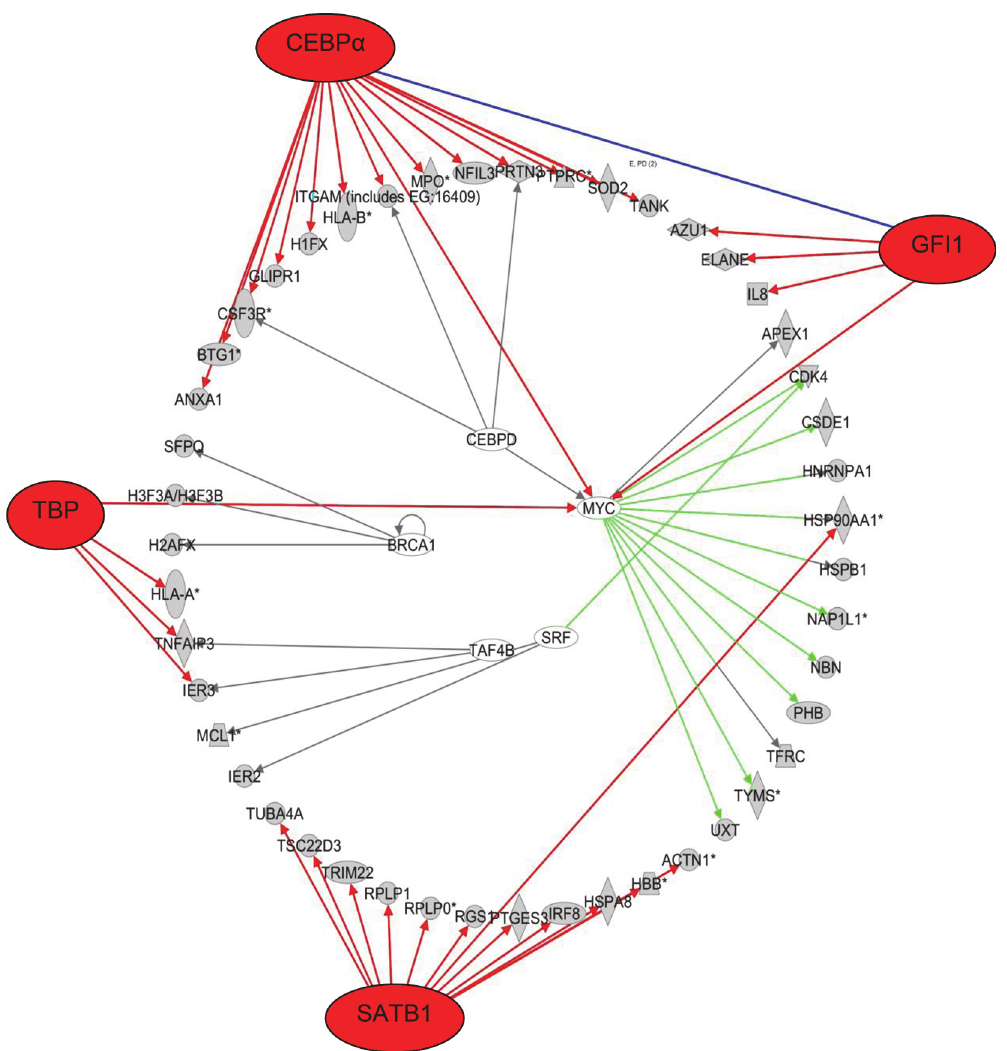
Fig 4. Transcription network visualization plot for patient 3. Transcription network plot showing transcription factors (outer ring/ inner ring) that are predicted responsible for differential expression of shown target molecules (middle ring) between diagnosis and relapse of patient 3. A few transcription factors ( CEBPA , GFI1 , SATB1 and TBP ) are responsible for the major changes in the differentially expressed target